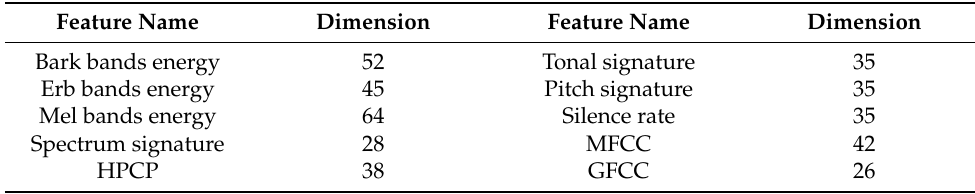
Table 1. The features picked up by the Freesound feature